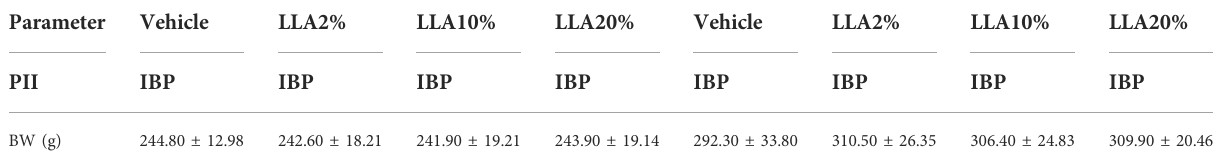
TABLE 4 PII and body weight of the rats topically treated with linalool + linalyl acetate combinations.